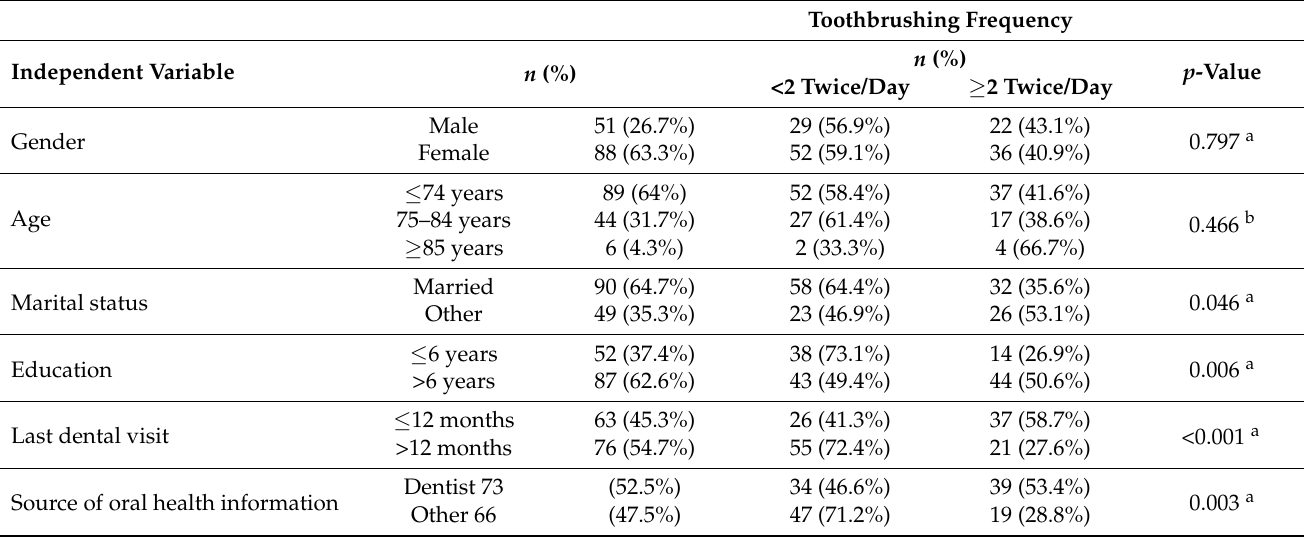
Table 4. The association of sociodemographic characteristics, dental visitation habits and source of dental hygiene information with the recommended toothbrushing frequency in dentate participants.